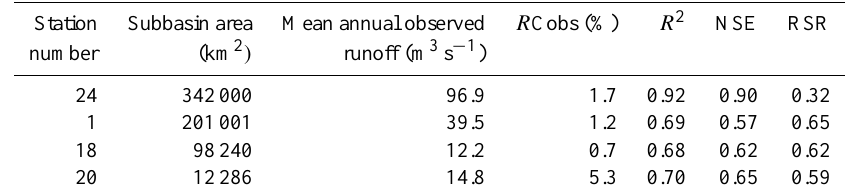
Table 1. Model evaluation measures for runoff for selected stations, ordered by basin size.